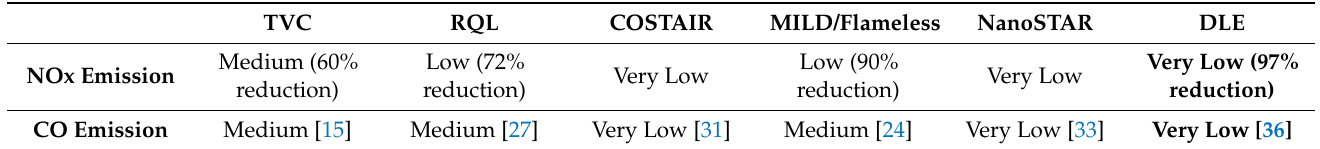
Table 1. Summary of combustor technologies in modern gas